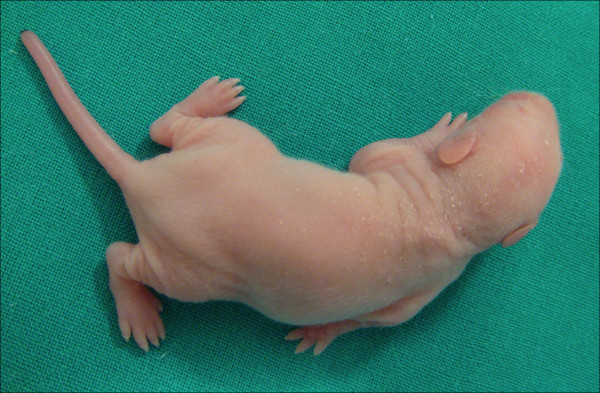
10-days-old rat (five days after surgery) showing shoulder paralysis and lack of elbow flexion after surgery.